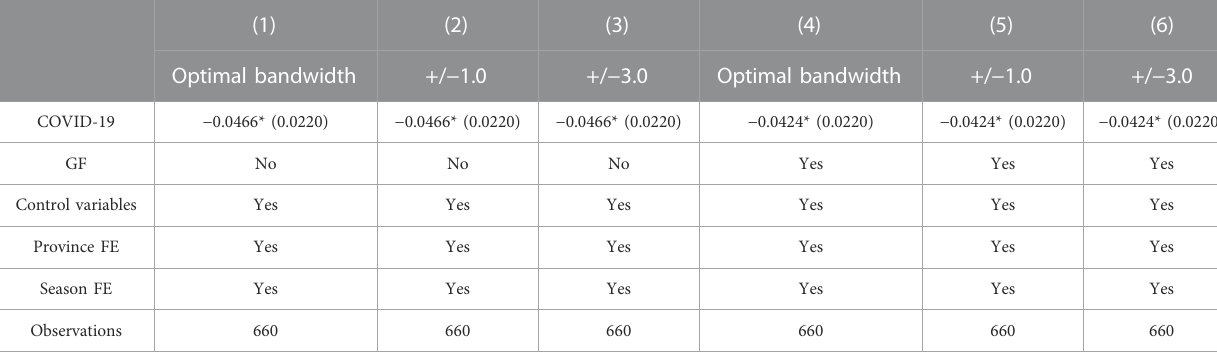
TABLE 4 Benchmark regression results II.